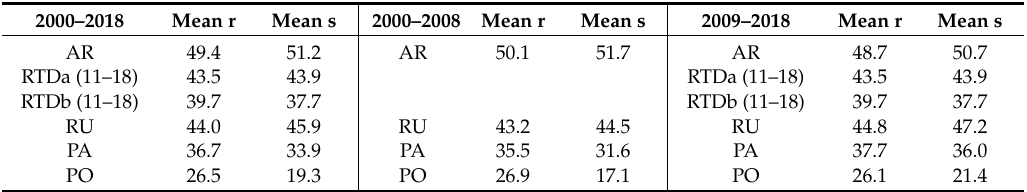
Table 2. Recruitment vs. stock, female %, Mean,